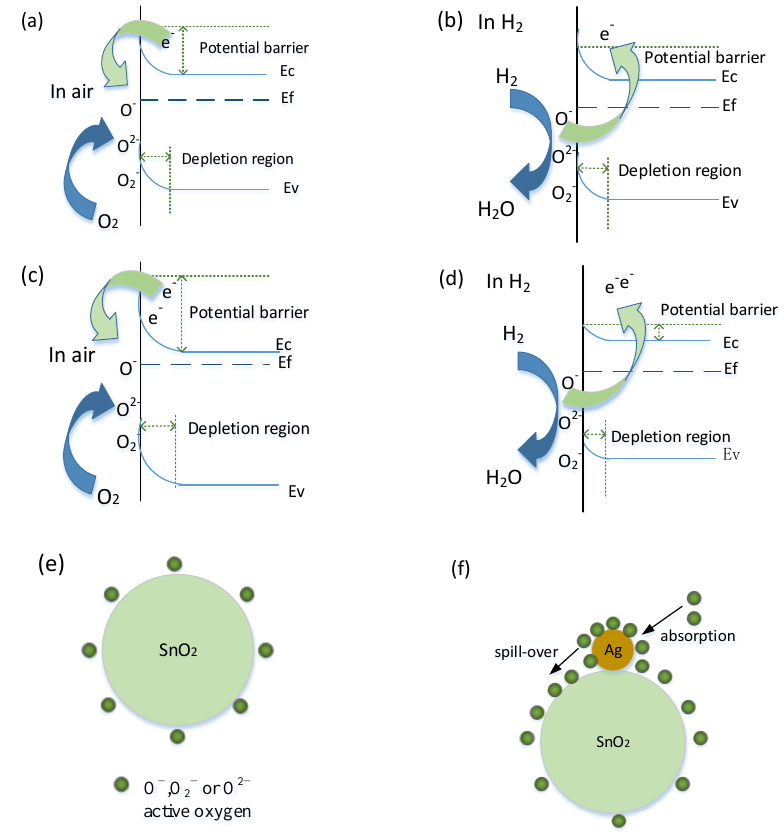
Figure 11. The sensing mechanism of pure and Ag-doped SnO 2 : ( a ) pure SnO 2 in air; ( b ) pure SnO 2 in H 2 gas; ( c ) Ag-doped SnO 2 in air; ( d ) Ag-doped SnO 2 in H 2 gas; ( e ) active oxygen distribution of pure SnO 2 ; ( f ) active oxygen distribution of Ag-doped SnO 2 .